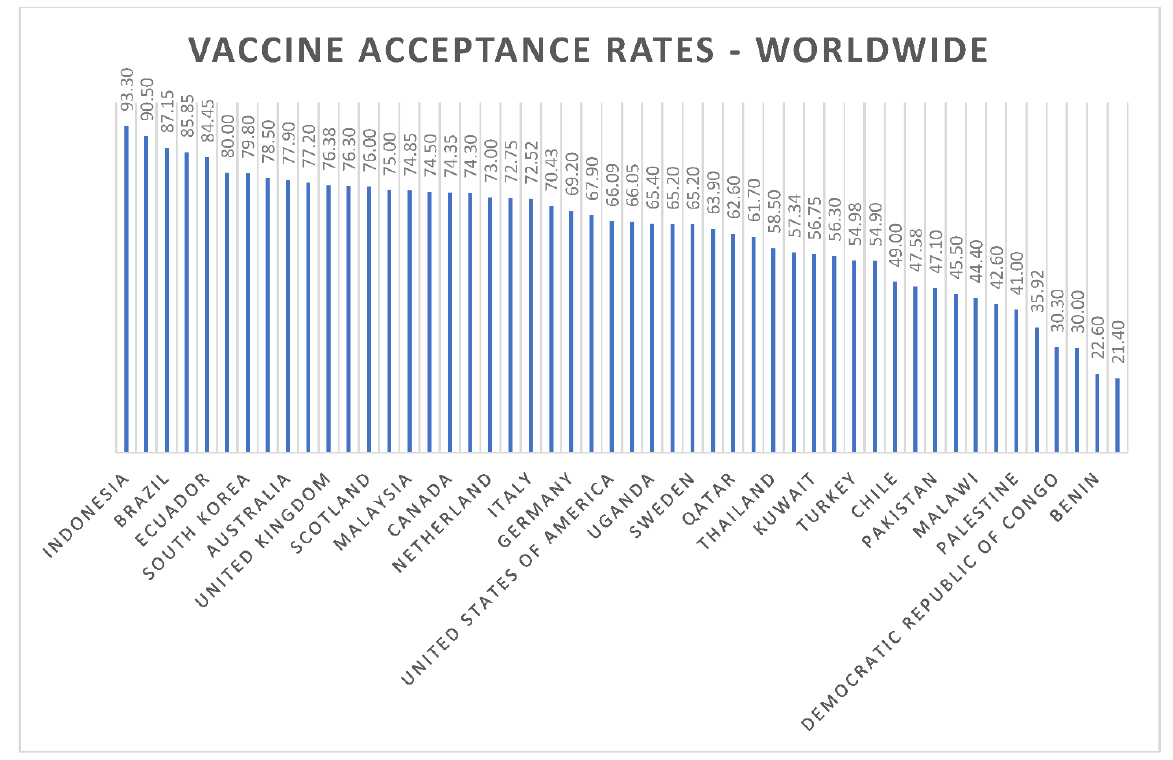
Figure 3. Worldwide COVID-19 vaccine-acceptance rates.